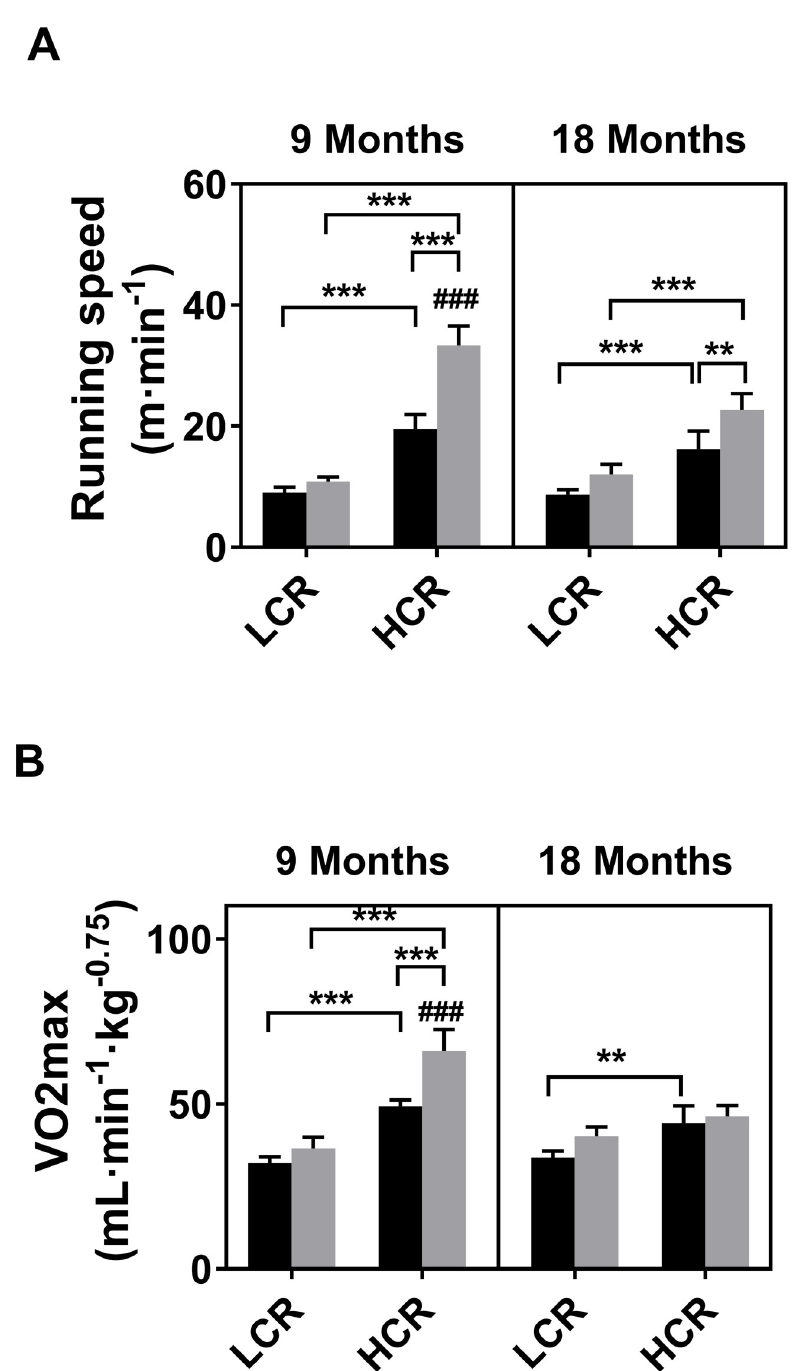
Fig 1. Effect of exercise training in aging LCR/HCR rats. Black and grey columns indicate sedentary and trained groups, respectively. Panel A: Running speed. Panel B: Oxygen consumption expressed in volume per minute, normalized to scaled body weight. P values: �� , < 0.01; ��� , < 0.001; ### , < 0.001, different from respective HCR at 18 months.